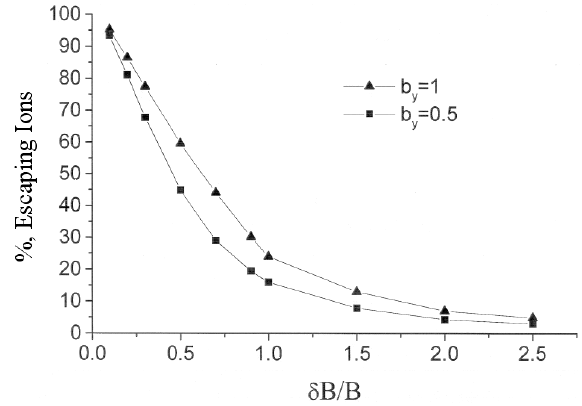
Fig. 7. The same as in Fig. 6 for escaping ions (crossing the flanks).